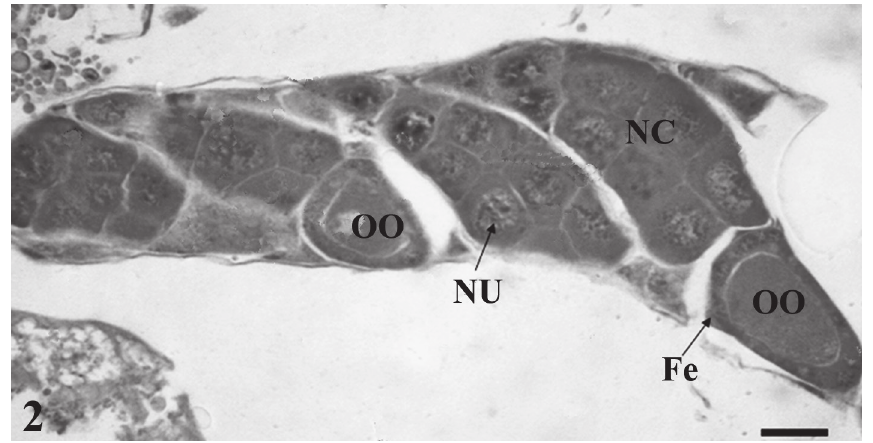
Figure 2 - Follicle (oocyte + nurse cells) of a newly-emerged females of Palmistichus elaeisis (Hymenoptera: Eulophidae). OO- oocyte, NU- nucleus of the nurse cells, NC- nurse cells, Fe– follicular epithelium. Bar: 10µm.